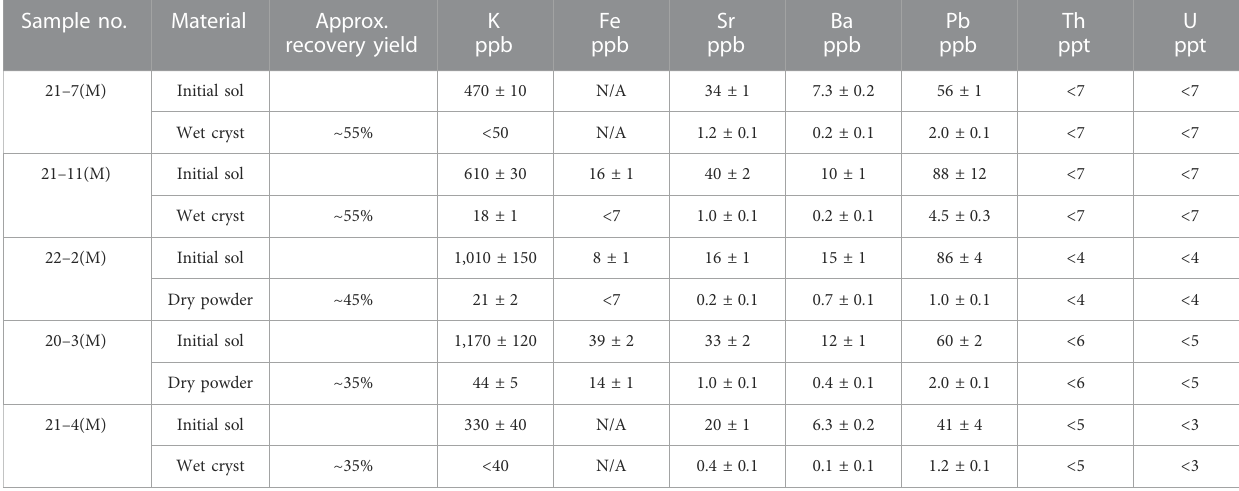
TABLE 4 The ICP-MS result of the mother solution recovery experiment in different batches of mass production. It is marked as (M) for the naming. In this experiment, the Initial solution means the initial mother solution and the Wet crystal means recrystallized and washed crystal. If the purity is not accepted, then additionalrecrystallization isrequired, sothe purity wascon fi rmed fi rst byICP-MS before drying andthen dried thoroughly. The wetcrystal consists of 73% ±2% NaIandextrawater andethanol,sothe impurityconcentrationiscalculated as 73%NaI.Uncertainties aregivenat90%C.L,andupperlimitsaregivenat95%C.L. Sample